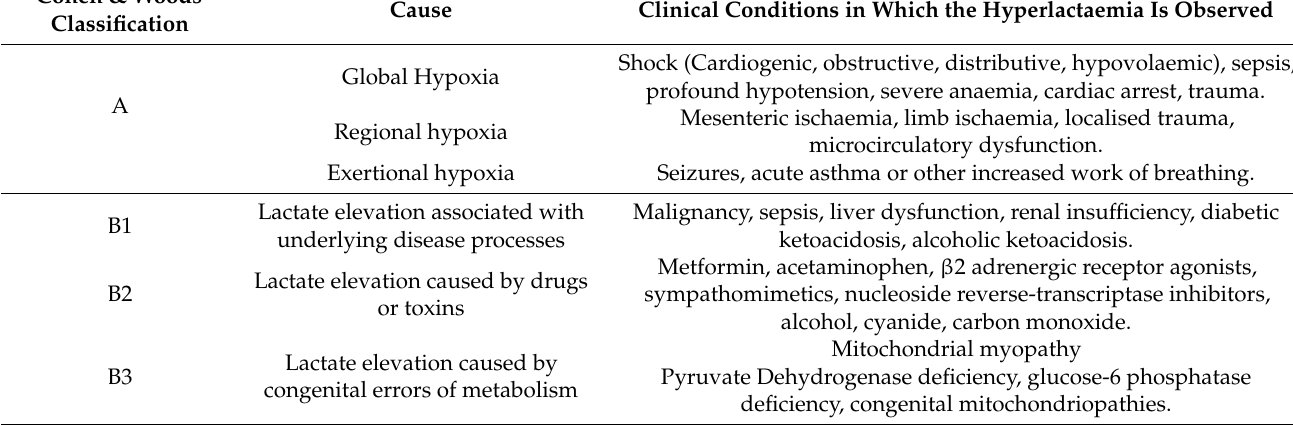
Table 1. Cohen and Woods’ classification of hyperlactataemia; Type A occurs in the presence of tissue hypoxia, while Type B occurs in the absence of tissue hypoxia. Key evidence demonstrating the association of hyperlactataemia with patient outcome in each setting is highlighted, providing justification for serial lactate